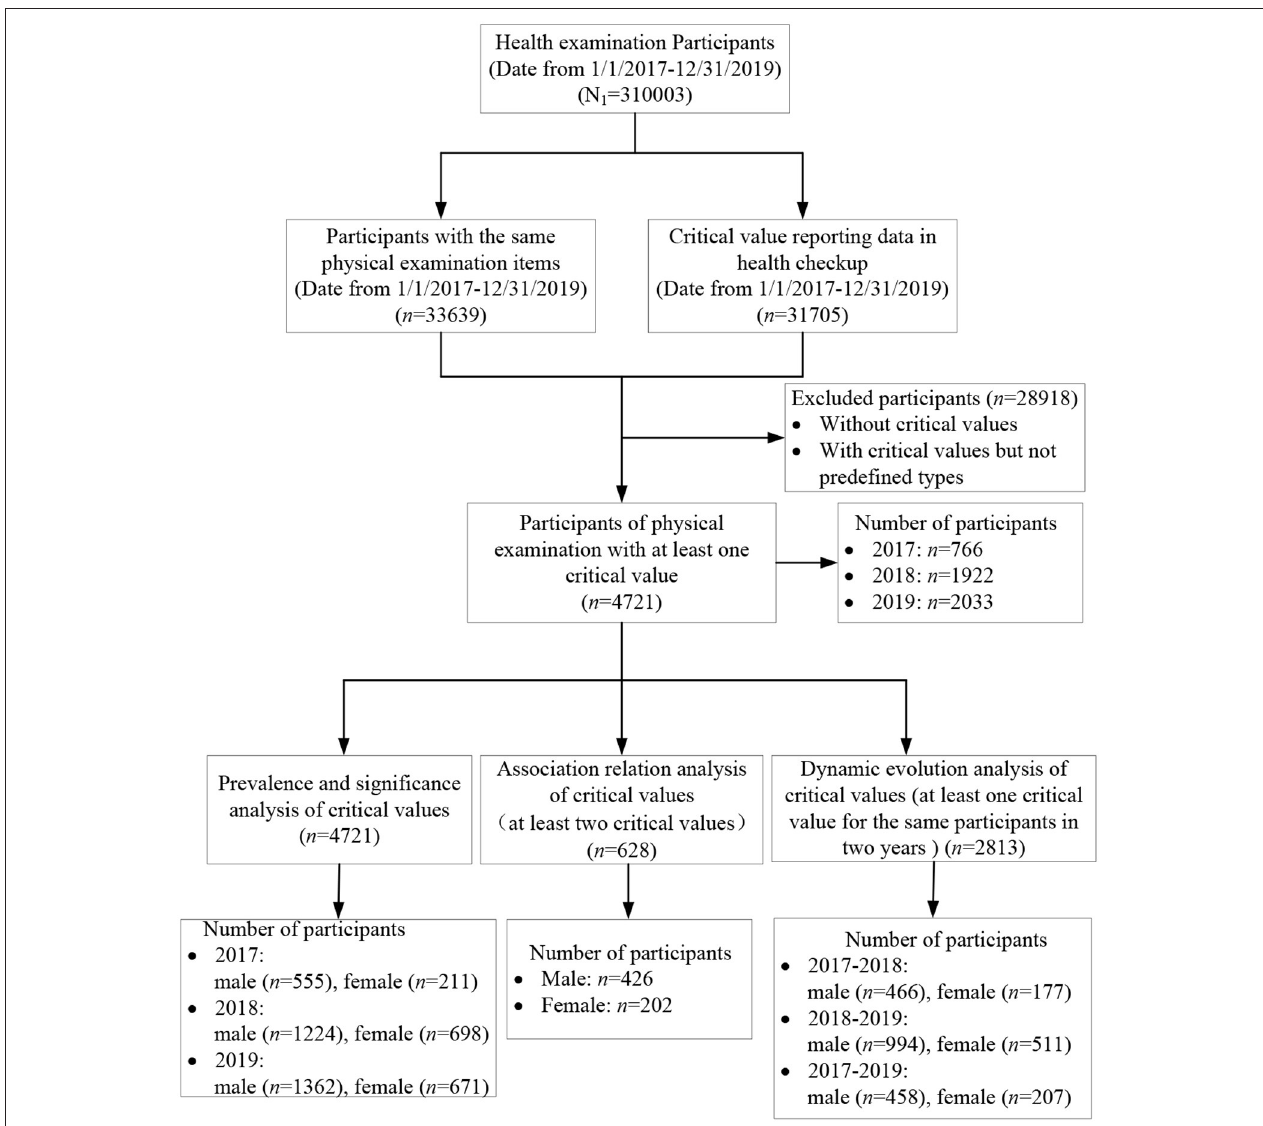
FIGURE 1 | Study design and flow